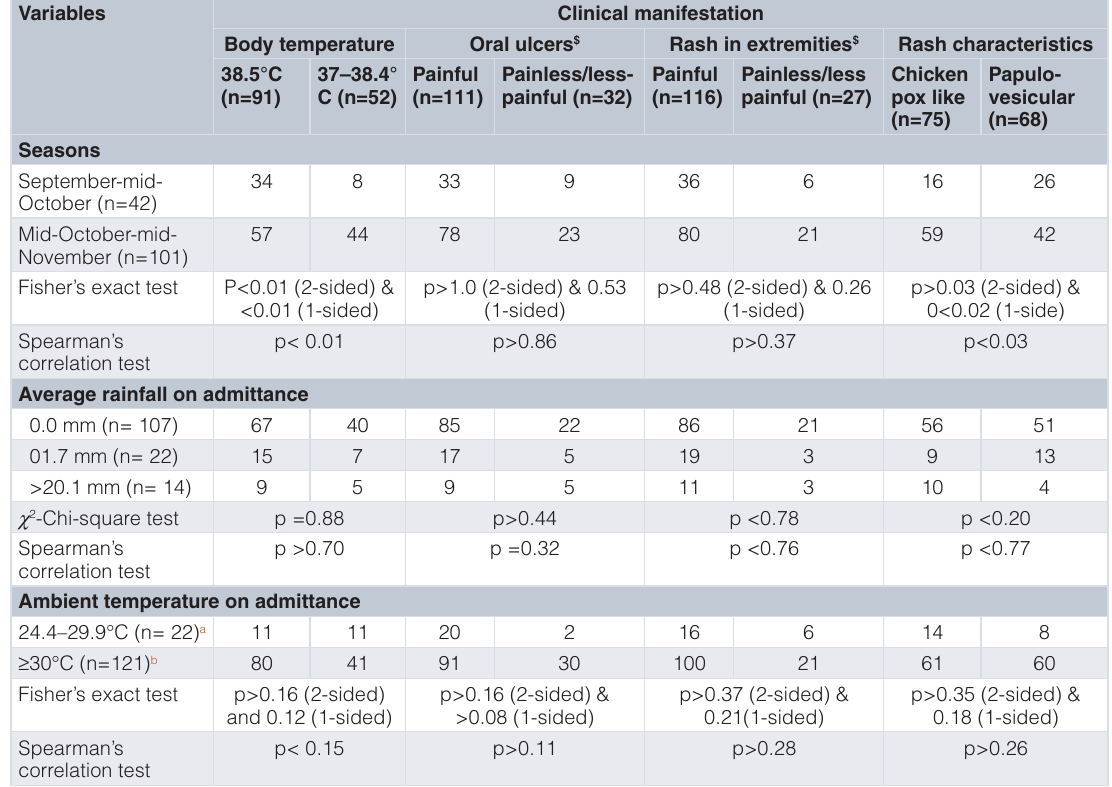
Table 3. Composite table showing association of HFMD clinical features with season/local climate.